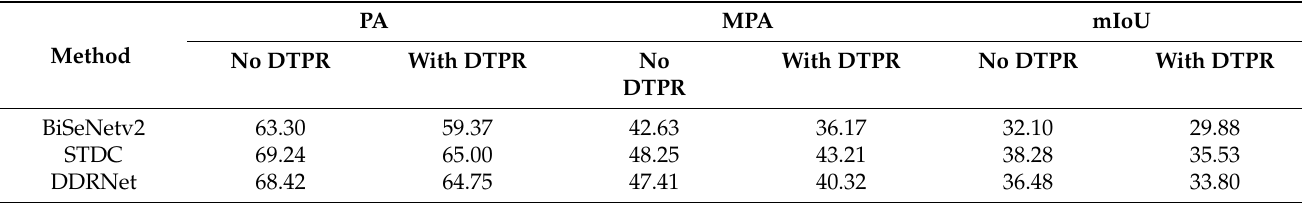
Table 7. Comparison of the real-time model on the MHPv2.0 validation set.